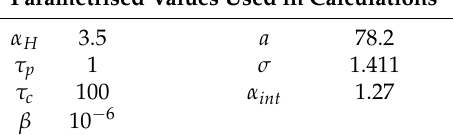
Table 1. Parametrised values used in the model, unless otherwise stated. The photon lifetime τ p was used to normalise the carrier lifetime τ c , which is typically 2–3 orders of magnitude larger than τ p . We have chosen values for α H and β to match those in similar works [18,28]. Values for a , σ , and α int were obtained through fitting our expression for gain to that which was measured, shown in Figure